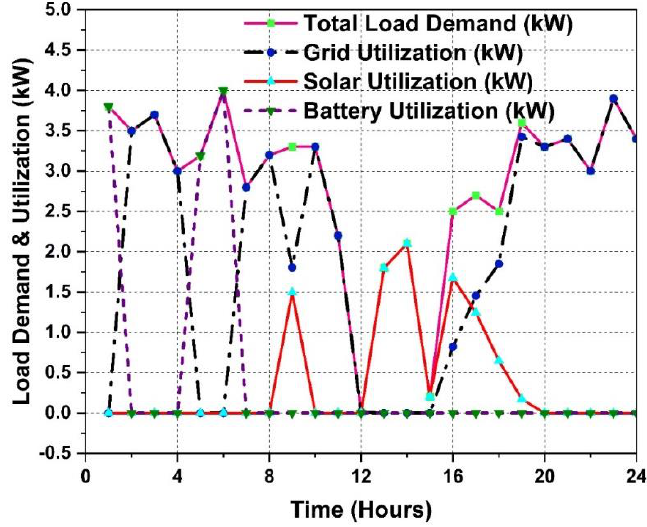
Figure 12. Load demand and resource utilization (on−grid ).